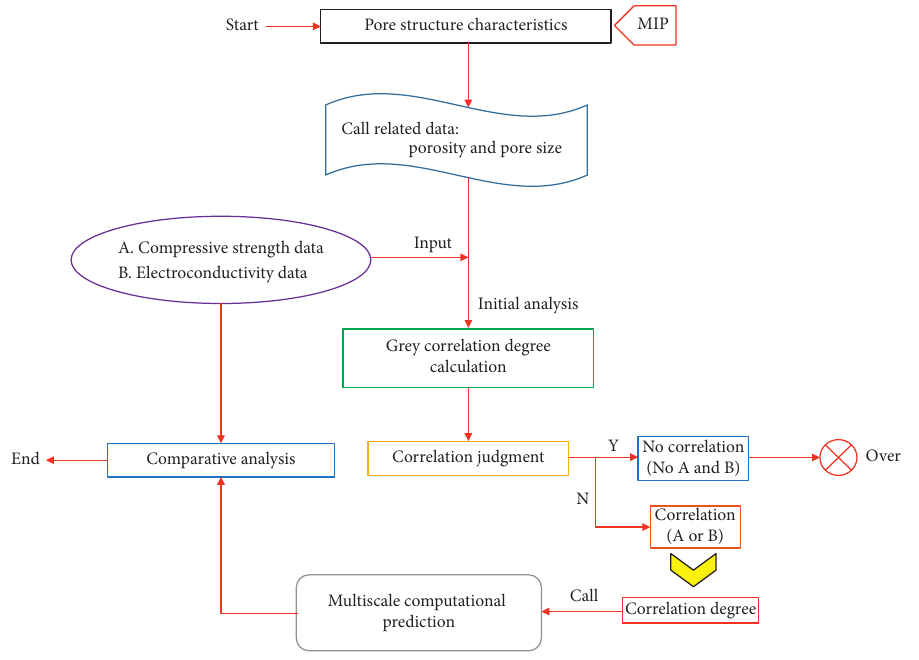
Figure 15: Grey correlation calculation